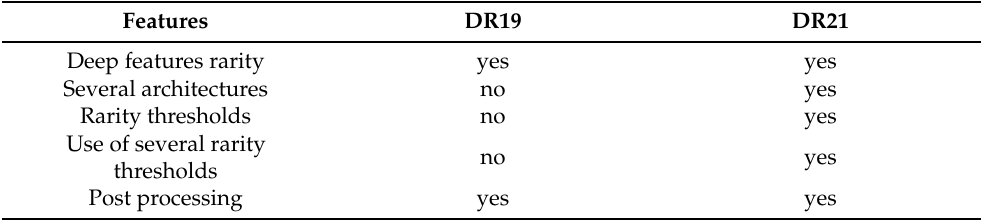
Table 5. DR19 versus DR21